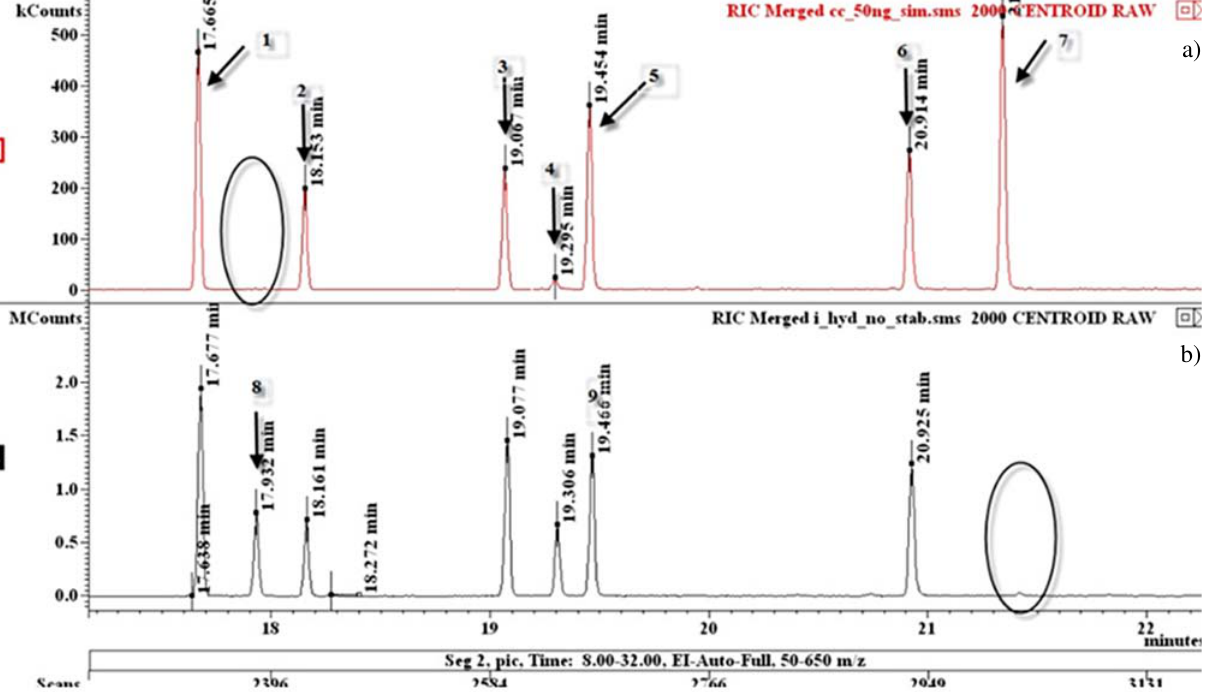
Figure 1. Chromatograms of standard solutions after; a) hydrolysis in presence of stabilizer (1. vanillic acid; 2. trans-o -coumaric acid; 3. syringic acid; 4. cis -ferulic acid; 5. trans-p -coumaric acid; 6. trans -ferulic acid; 7. trans -caffeic acid; 8. cis-p- coumaric acid; cis -caffeic acid (minimal peak at t R 19.99 min); b) hydrolysis without stabilizer (1. vanillic acid; 2. trans-o -coumaric acid; 3. syringic acid; 4. cis -ferulic acid; 5. trans-p -couma- ric acid; 6. trans -ferulic acid; 7. trans -caffeic acid (missing peak); 8. cis-p -coumaric